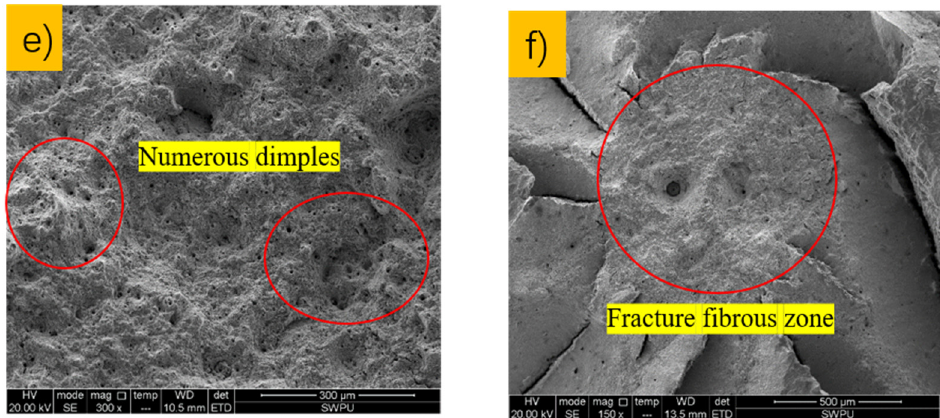
Figure 18. Tensile fracture morphology after stress corrosion with constant load in liquid phase: ( a ) C110-1 ductile fracture with secondary crack; ( b ) C110-2 ductile fracture with a high area-reduction rate; ( c ) C110-1 fracture with bigger area of the shear lip; ( d ) C110-2 fracture with smaller area of the shear lip; ( e ) C110-1 steel fracture with fibrous zone of many dimples; ( f ) C110-2 fracture with fibrous zone.